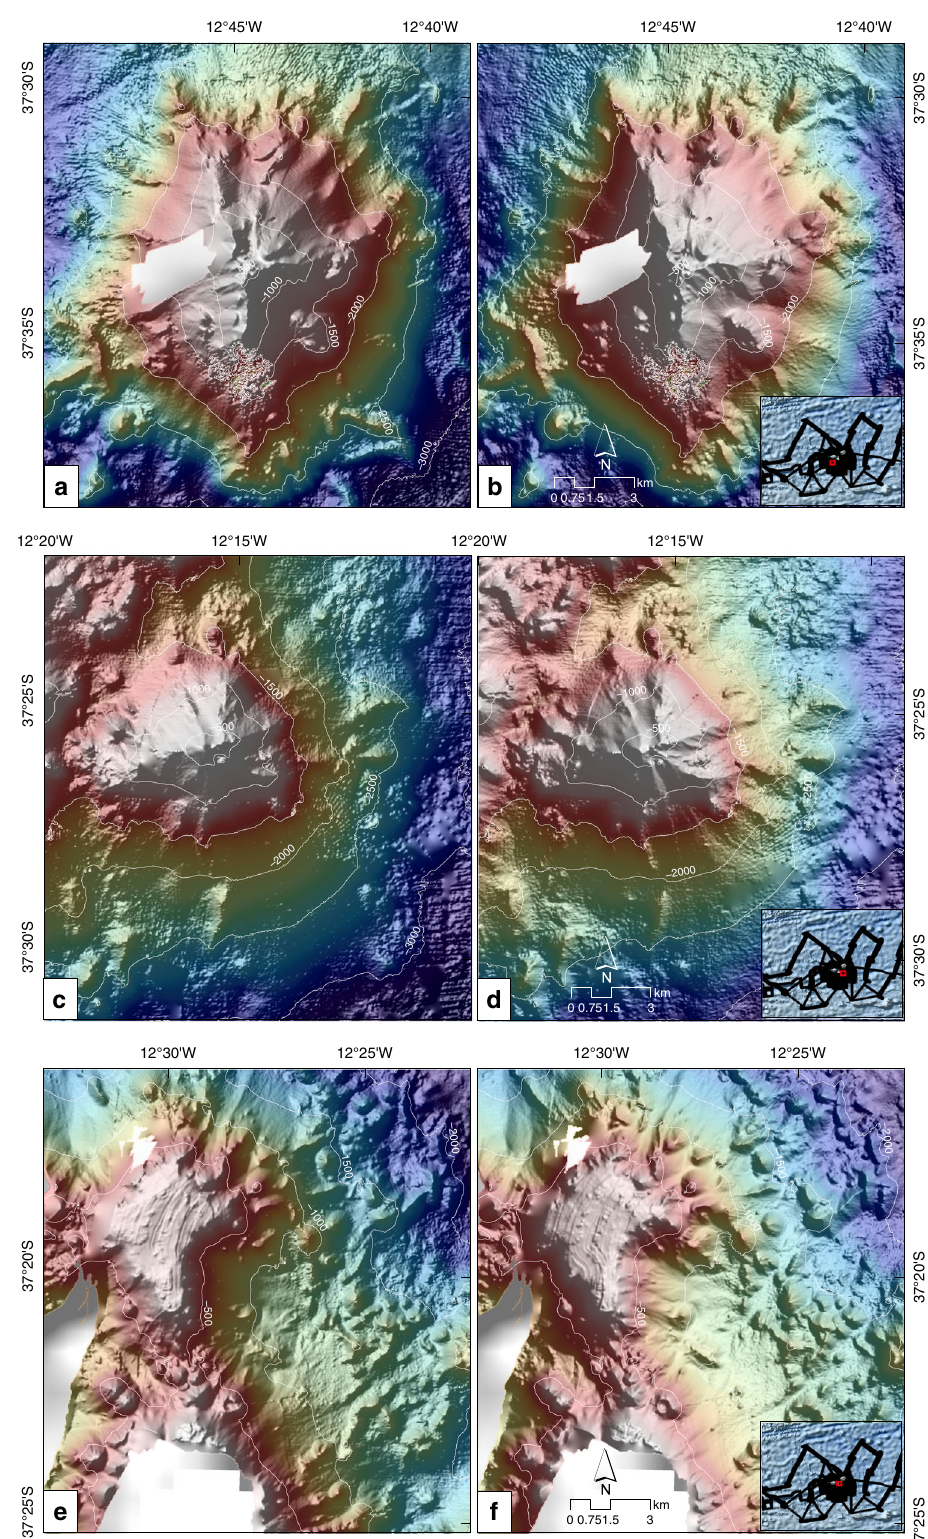
Fig. 4 Central area bathymetry close-ups. a , b Bathymetry of the Rockhopper Seamount. The hillshade is illuminated by an azimuth of 315 and 45°, respectively. c , d Bathymetry of the Isolde Seamount. The hillshade is illuminated by an azimuth of 315 and 45°, respectively. e , f Bathymetry of the small plateau to the north of Nightingale Island and east of Inaccessible Island. The hillshade is illuminated by an azimuth of 315 and 45°,